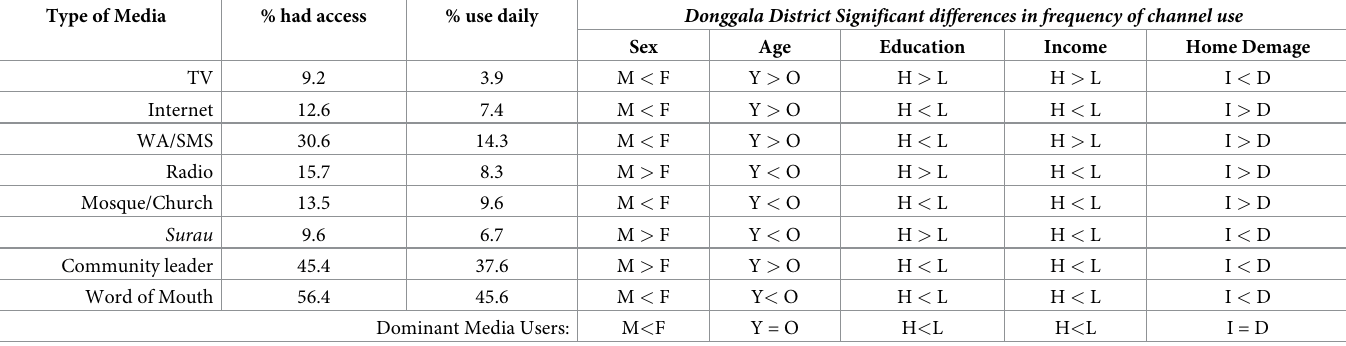
Table 3. Overall channel use patterns in Donggala